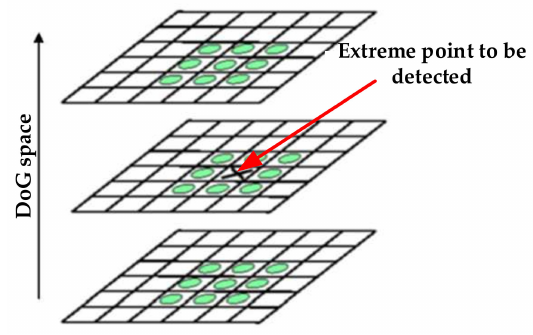
Figure 4. Schematic diagram of extreme point detection of DoG